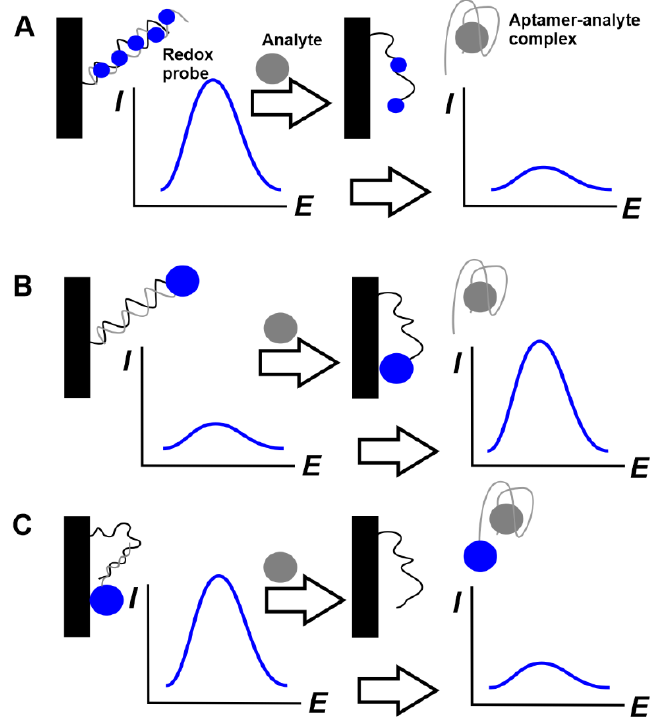
Figure 12. Schematic outline of the aptasensor with a free (A) and covalently attached (B,C) redox